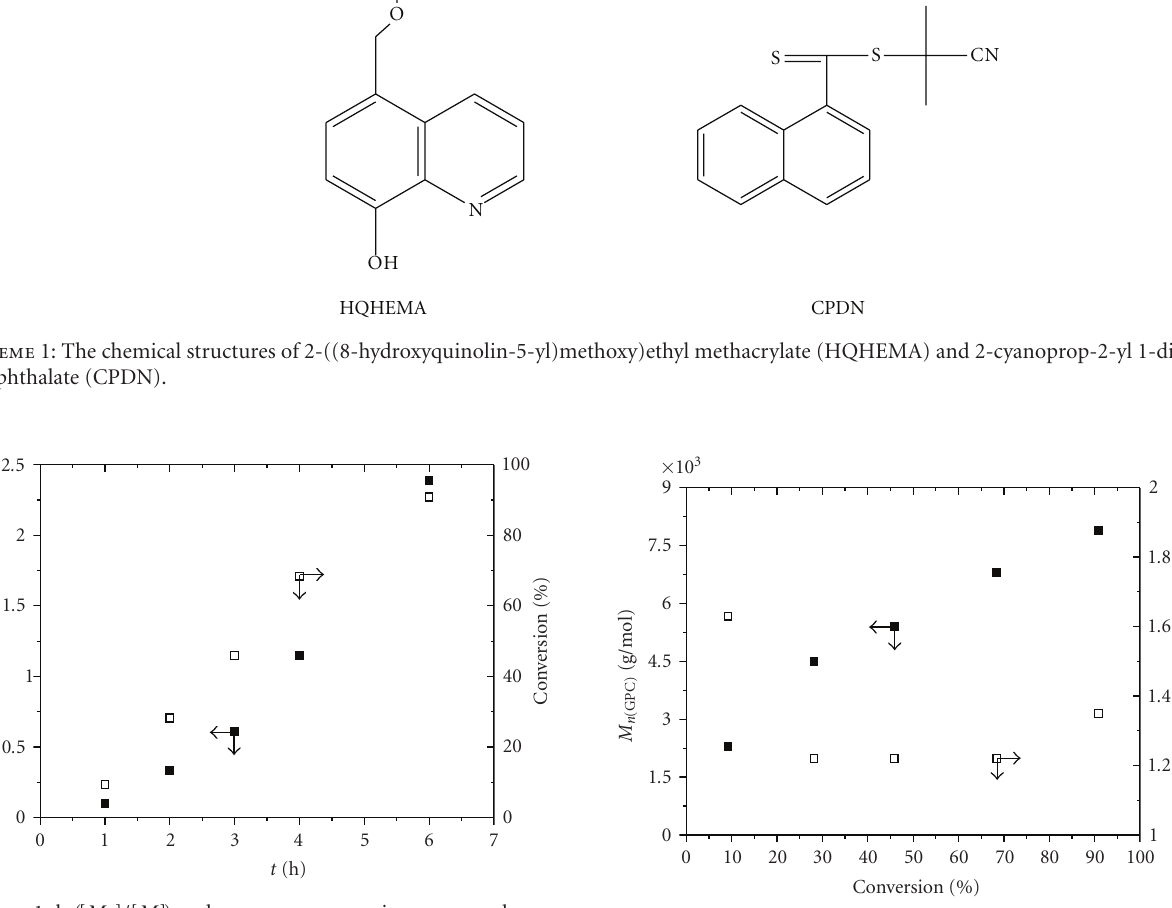
Figure 2: Dependence of molecule weights and molecule weight distributions on monomer conversions for RAFT copolymerization of HQHEMA and MMA. Polymerization conditions are the same as in Figure